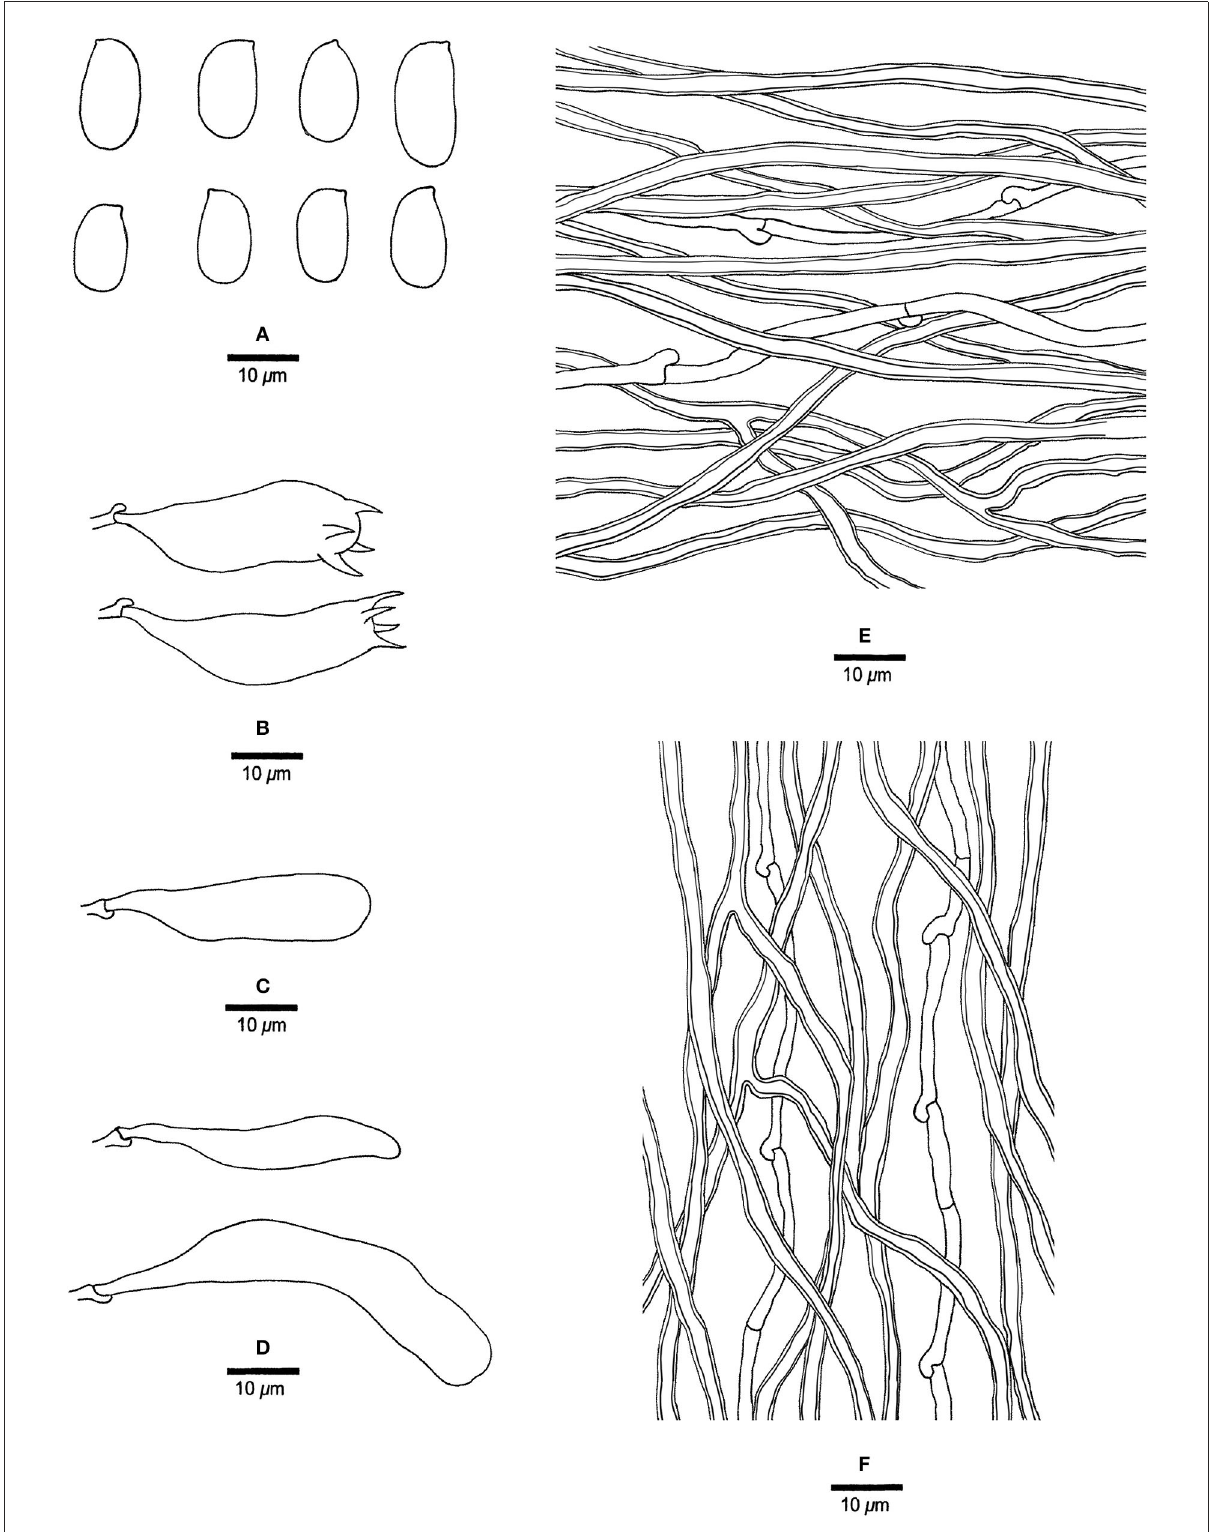
FIGURE9 Microscopic structures of Mariorajchenbergia epitephra (drawn from Coveny 219). (A) Basidiospores. (B) Basidia. (C) A basidiole. (D) Cystidioles. (E) Hyphae from subiculum. (F) Hyphae from tube